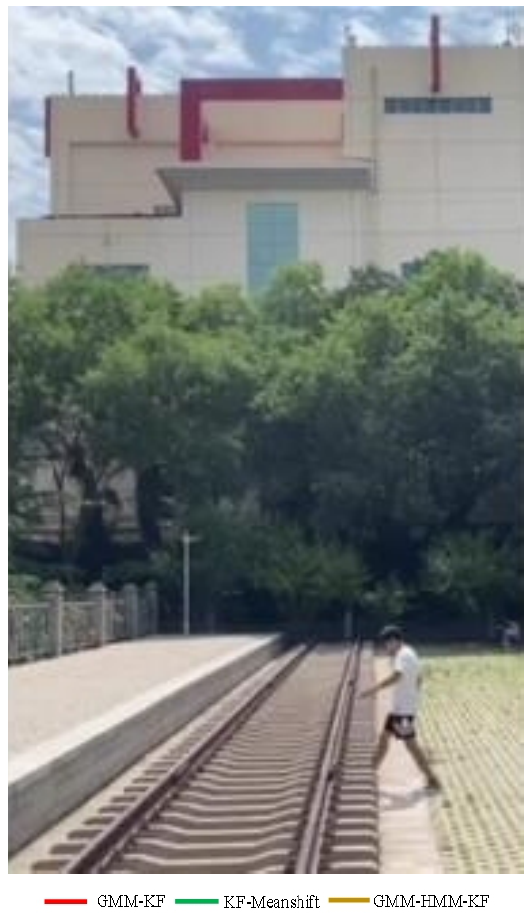
Fig. 9. The original image of the 499 th frame of video 2